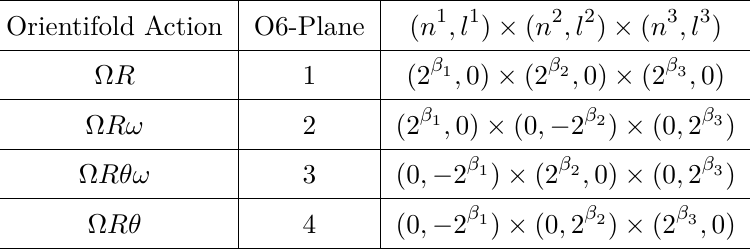
Table 2 . The wrapping numbers for four